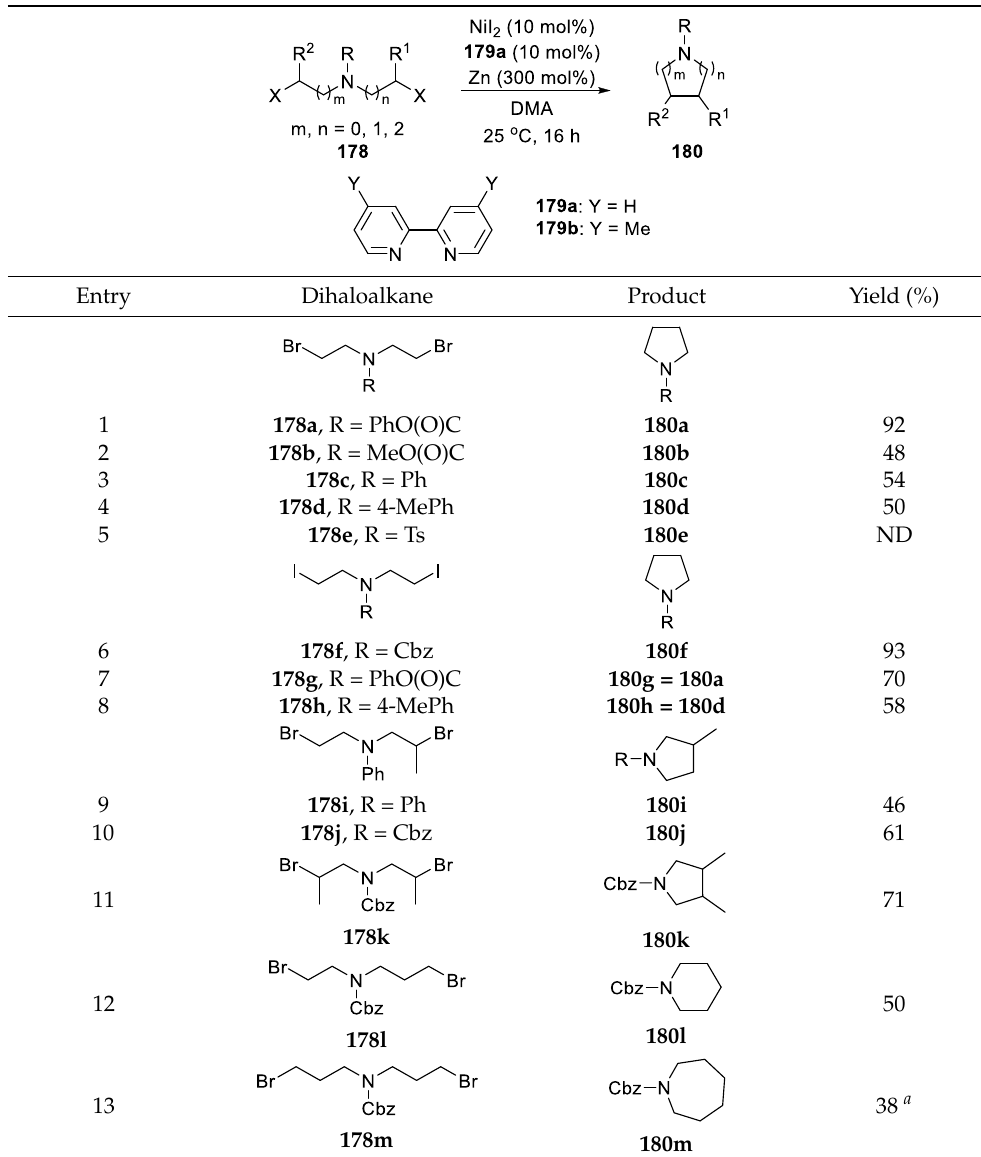
Table 4. Synthesis of azacycles via intramolecular cyclization of dihaloalkanes.